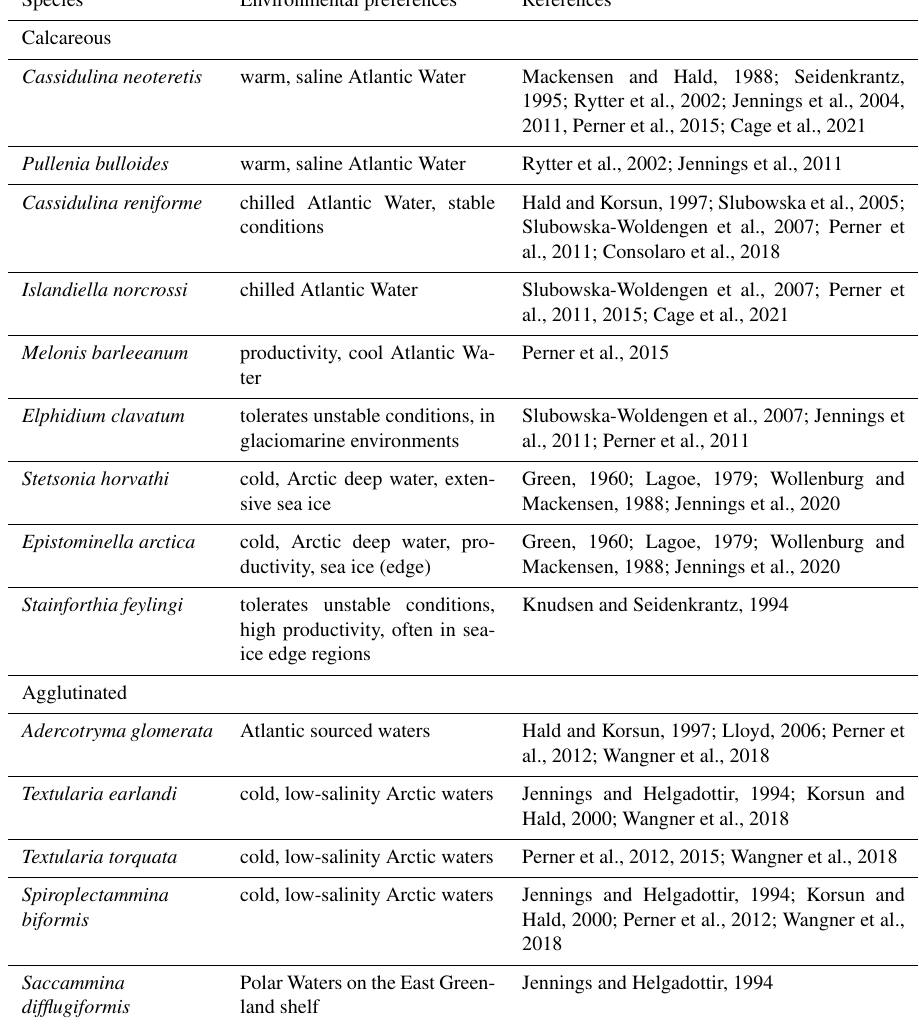
Table A3. List of benthic foraminiferal key species used for palaeoenvironmental reconstruction.